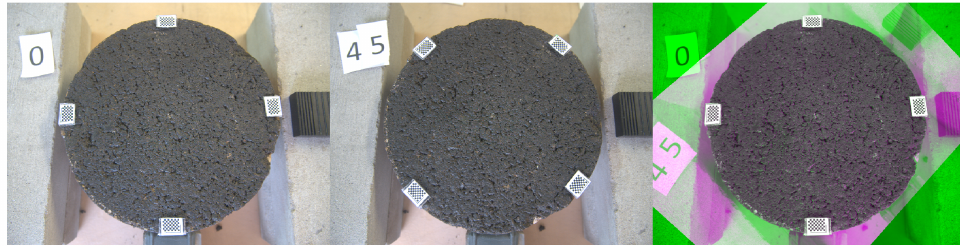
Figure 10. Triplet image. Left: 0th position. Centre: 45th position. Right: Overlapped after transformation 45th → 0th.